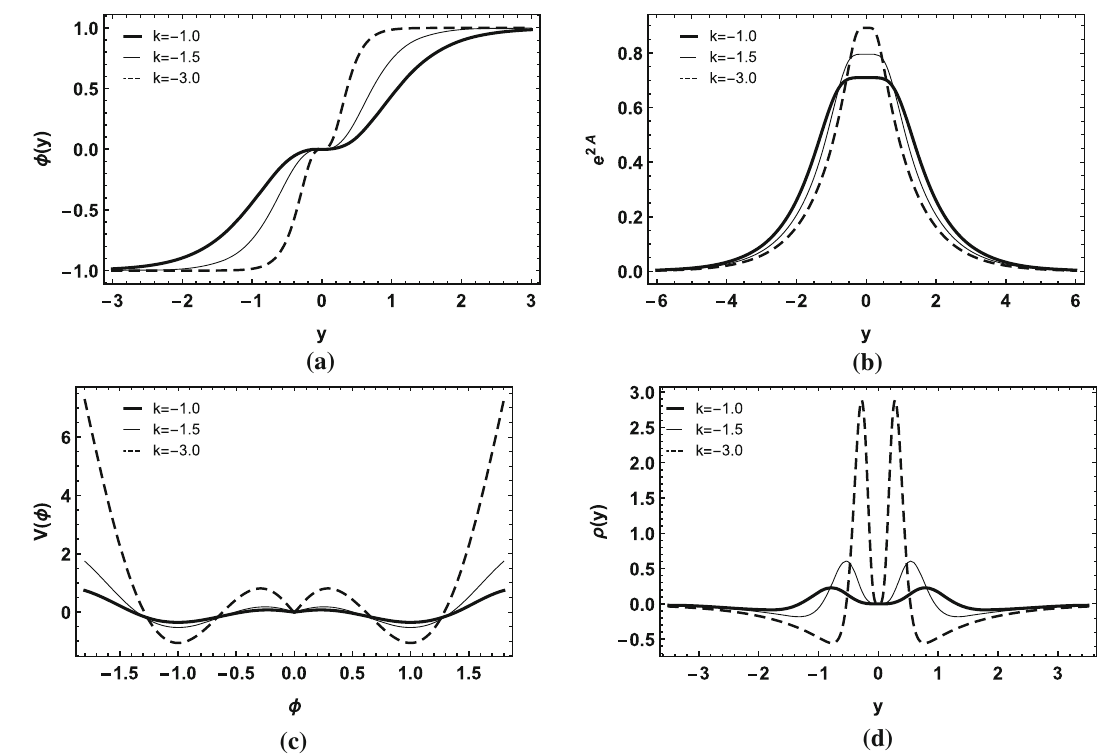
Fig. 3 Plots of the kink solution ( a ), warp factor ( b ), potential ( c ), energy density ( d ), for the fractional superpotential, where α = β =